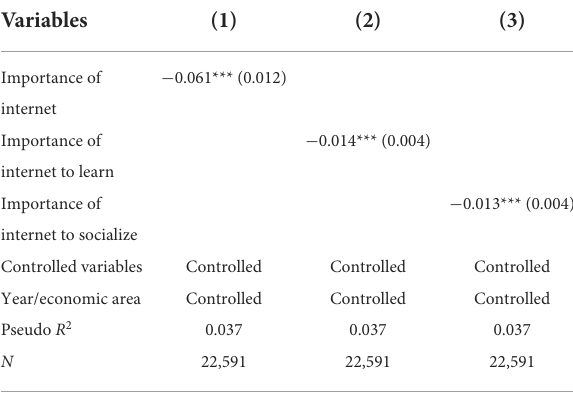
TABLE 3 Robustness test results. TABLE 4 Test results of Heckman